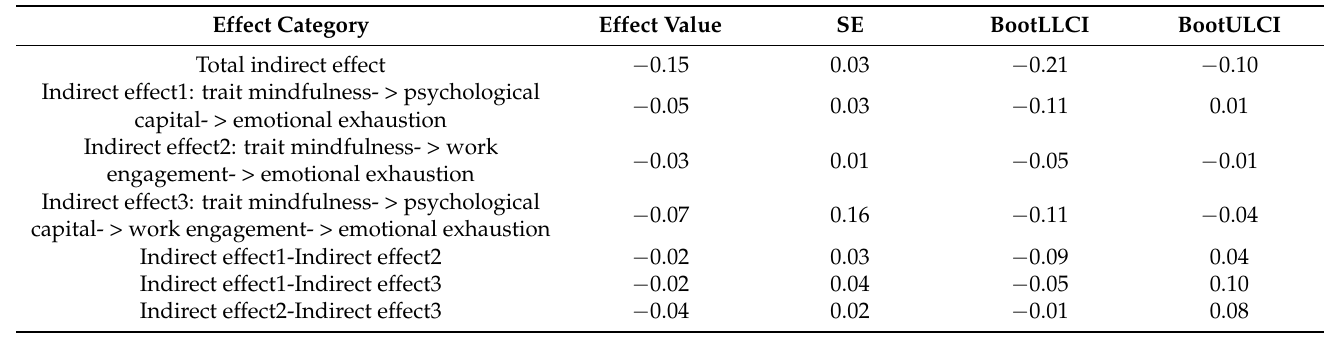
Figure 2. The chain mediating role of psychological capital and work engagement. Table 3. The chain mediating role of psychological capital and work engagement.